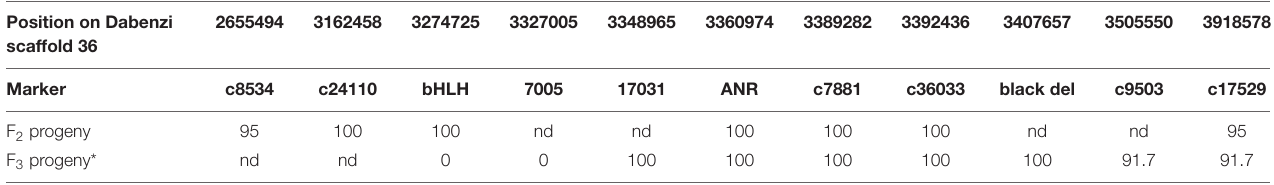
The “black” trait area for each population is highlighted in purple. The distances on ‘Dabenzi’ scaffold 36 between F 2 and F 3 recombinations are 1,263 kb and 178.5 kb, respectively. *F3 population1. nd, not determined. Values are expressed as percentage.